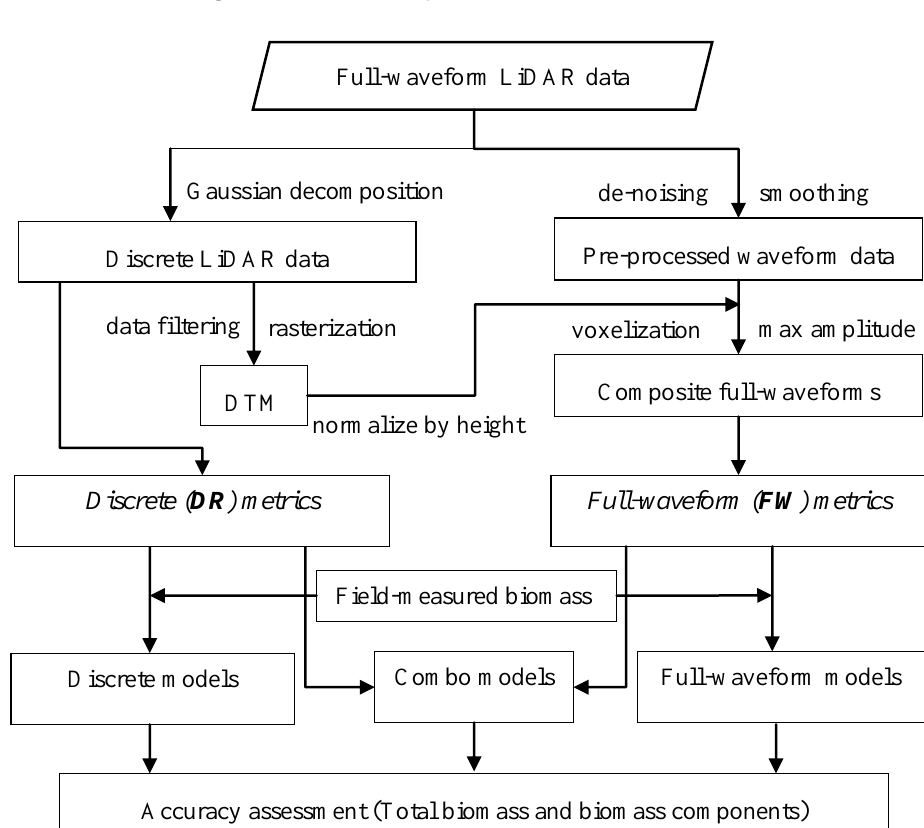
Figure 2. Technological route of this